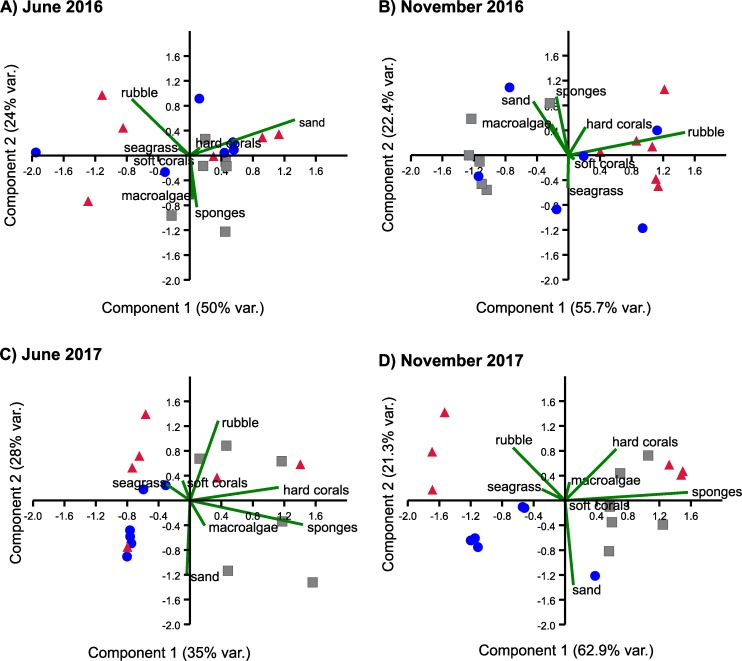
Principal component analyses of percentage of cover of types of substrates.Biplots on logit transformation of percentage of cover of seven types of substrate during four sampling periods (June and November 2016; June and November 2017) over three sampling zones within the Puerto Morelos reef lagoon, zone A (red triangles), zone B (blue dots), and zone C (grey squares). Each symbol represents a transect.